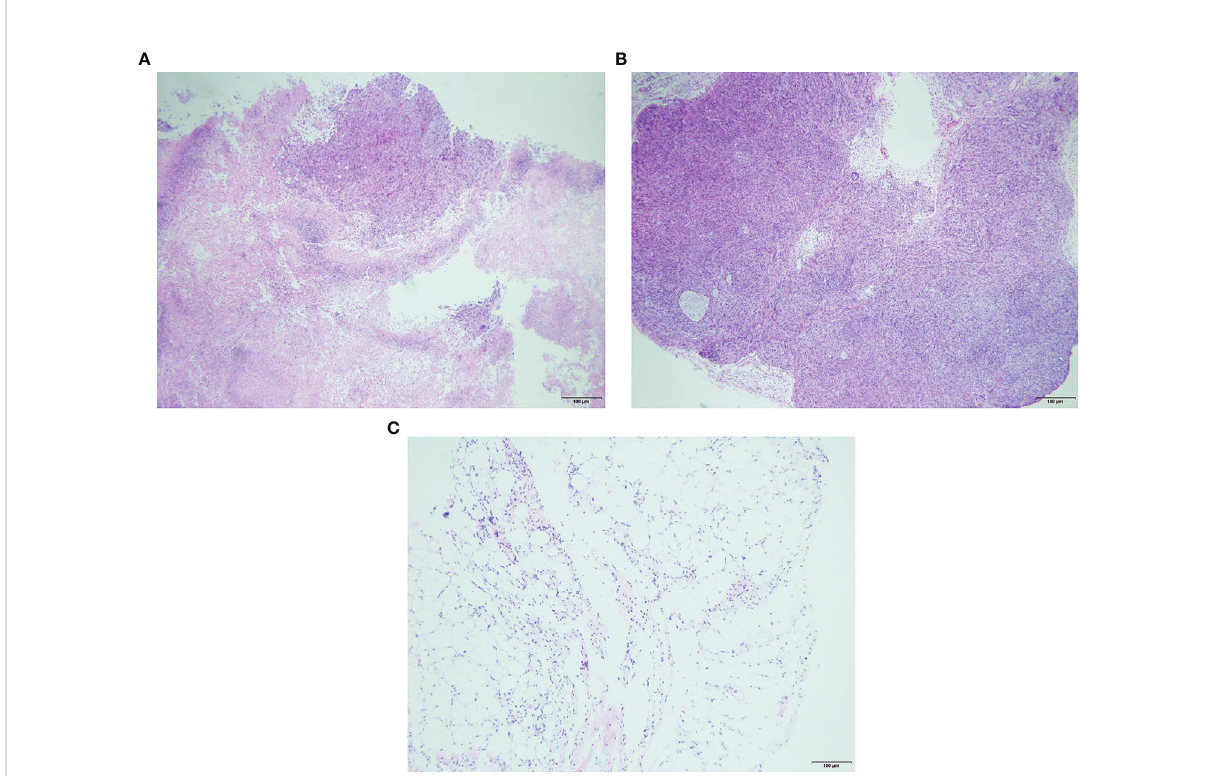
FIGURE 2 Representative hematoxylin and eosin (H&E) staining of tissue sections (right tumor of 4T1 mice) with obvious necrosis (A) , control tumor cells (B) , and peritumoral adipose tissue hyperplasia (C) after 3 days of epirubicin (EPI) gel